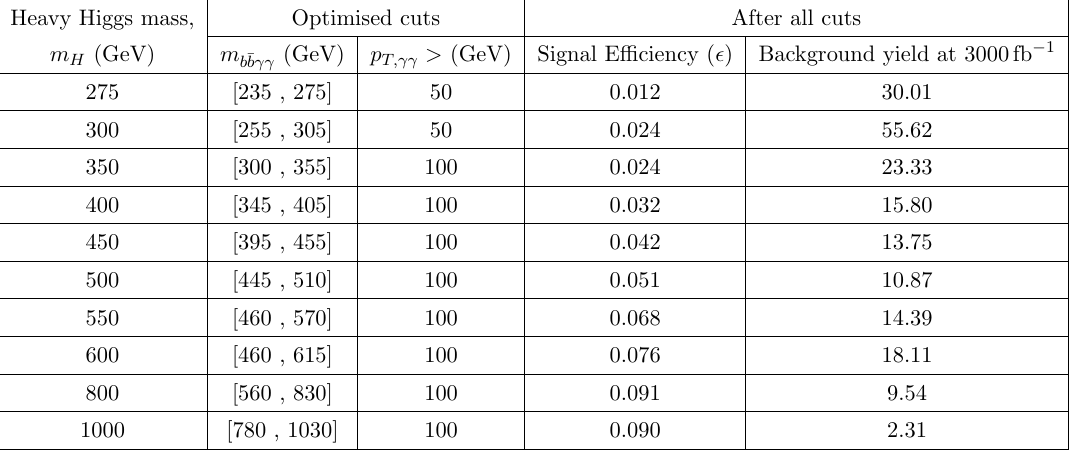
Table 3 . Details of the (cid:12)nal optimised cuts with signal e(cid:14)ciency and background yields after applying all cuts.